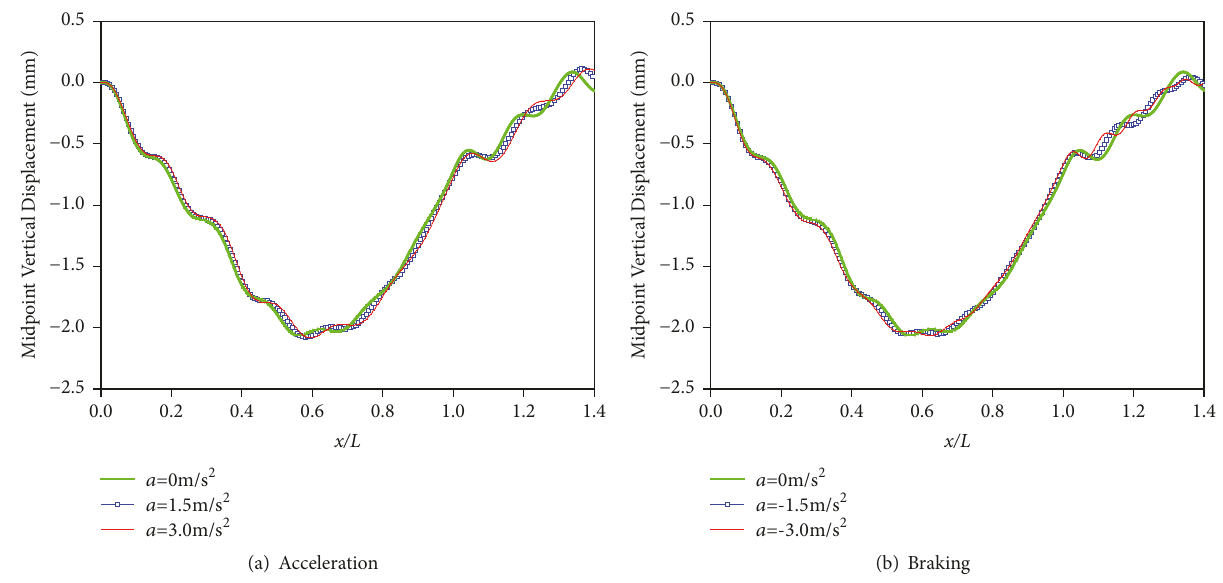
Figure 10: Vertical displacement of midpoint of simply supported beam during varied vehicle